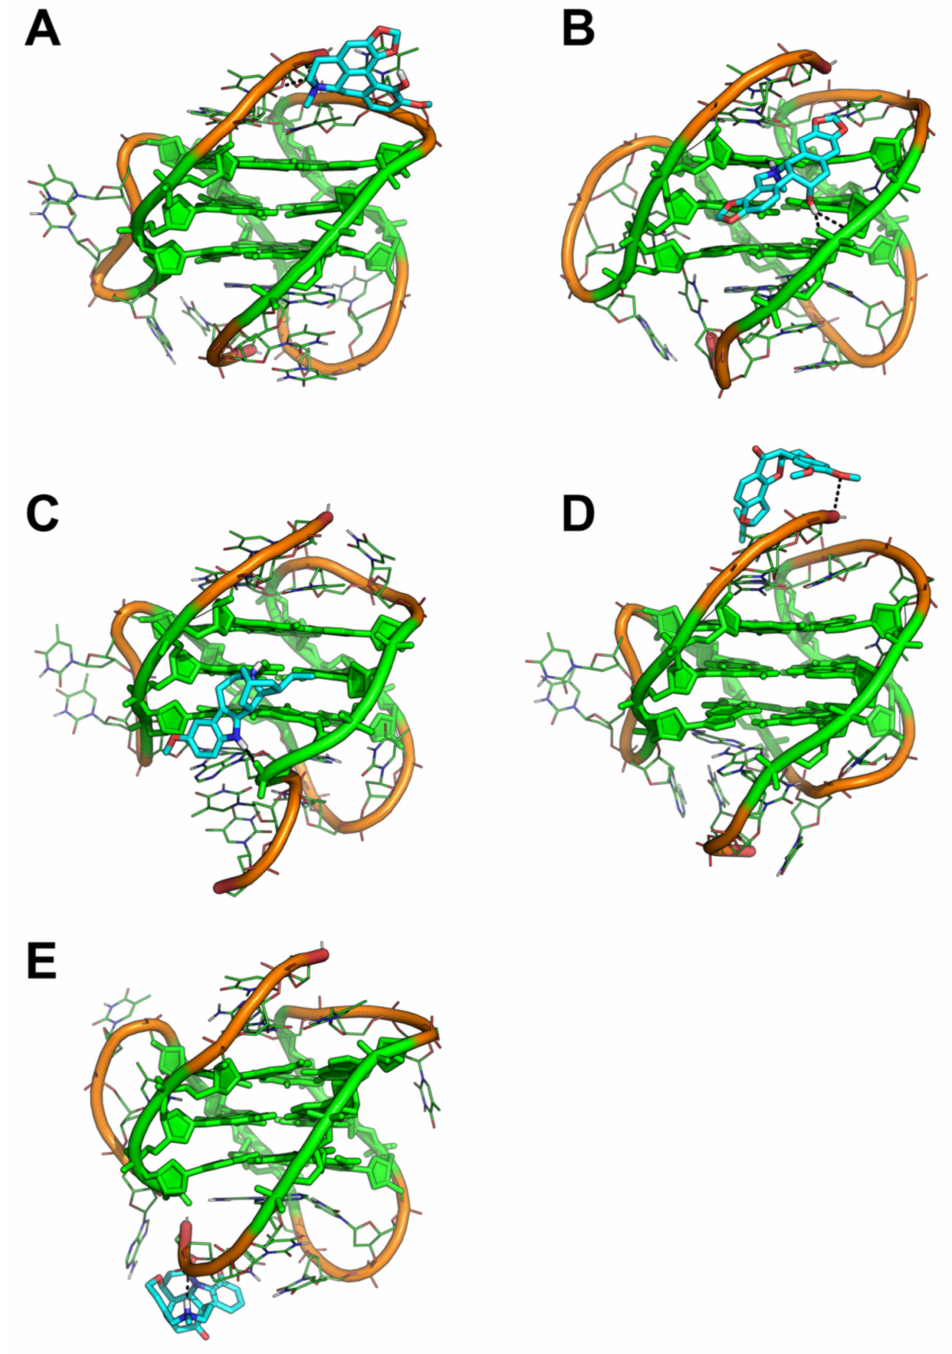
Figure 3. Representative binding conformation of selected ligands to tel 26 G4 extracted from MD trajectories. ( A ) tel 26 G4/Bulbocapnine; ( B ) tel 26 G4/Chelidonine; ( C ) tel 26 G4/Ibogaine; ( D ) tel 26 G4/Rotenone; ( E ) tel 26 G4/Vomicine. The G4 is shown as lines and cartoon. G nucleotides forming G-quartets are shown as green sticks with filled rings. Small molecules are shown as cyan sticks. Metal ions and water molecules have been omitted for the sake of clarity. tel 26 G4/ligand polar interactions are highlighted by black dashed lines. The same orientation of each tel 26 G4/ligand complex is shown, which was obtained by structural alignment on the G4 phosphate